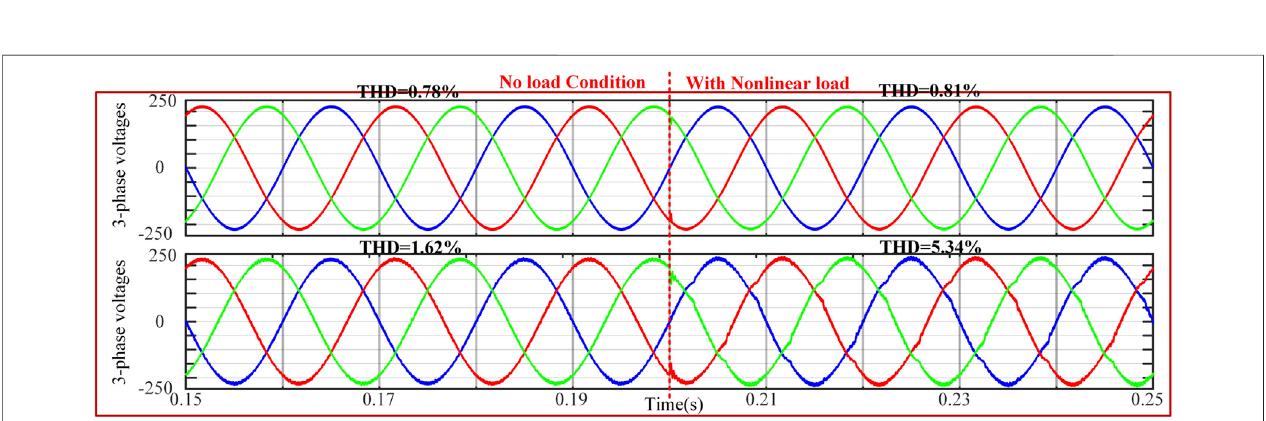
FIGURE 11 | Three-phase simulation results between proposed control and PI-based control suffering from nonlinear load.